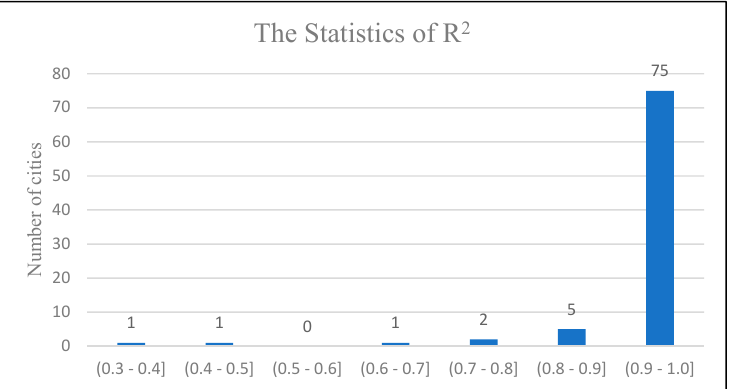
indexR 2 Figure 6. Distribution of R 2 which is calculated by the OSM road network density and population. Figure 3 shows a total of 72 cities with significant correlation with coefficient of determination R 2 above 0.7, accounting for 84.71%. These 72 cities experienced rapid economic development during the four years from 2014 to 2017, and with their municipal GDP increasing steadily year by year; 5 cities with coefficient of determination R 2 below 0.5, they are Shenyang, Urumqi, Dalian, Baotou, and Hohhot, respectively, and their R 2 are 0.499, 0.483, 0.342, 0.303, and 0.0005, respectively. The municipal GDP statistical data and the OSM road network density for these five cities are shown in